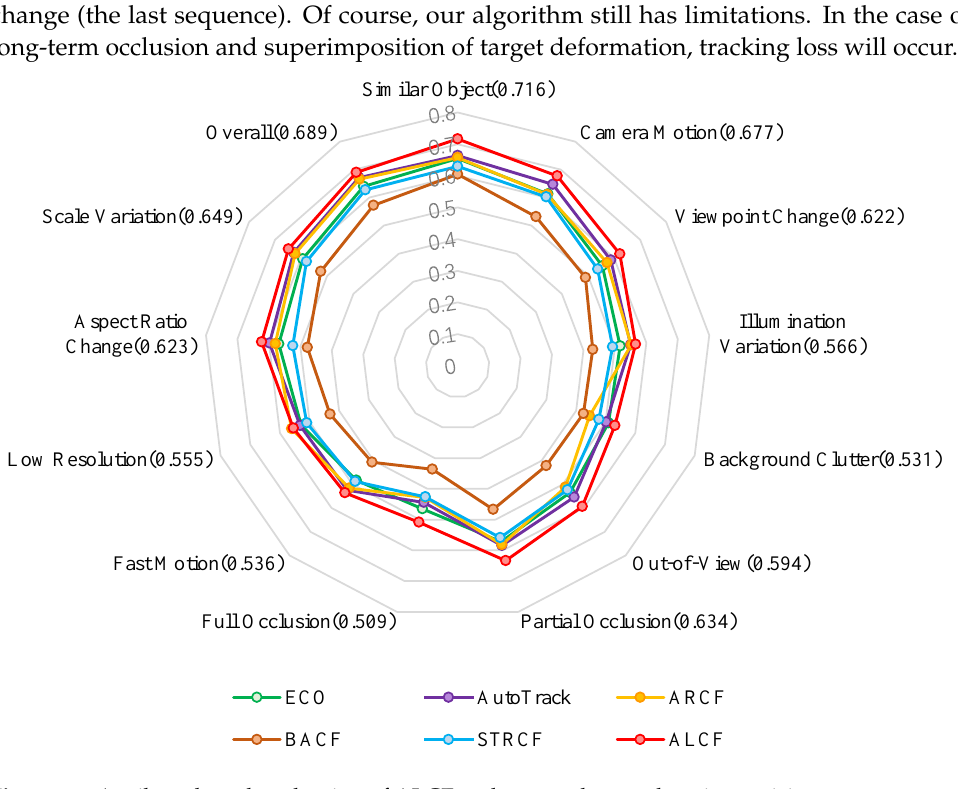
Figure 10. Attribute-based evaluation of ALCF and some other trackers in precision.